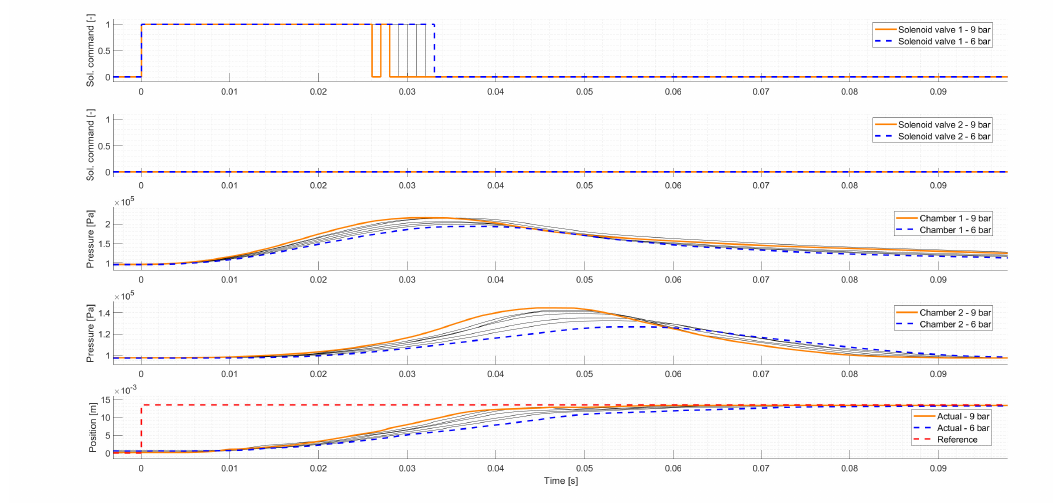
Figure 9. PID controller: Neutral to High gear changes